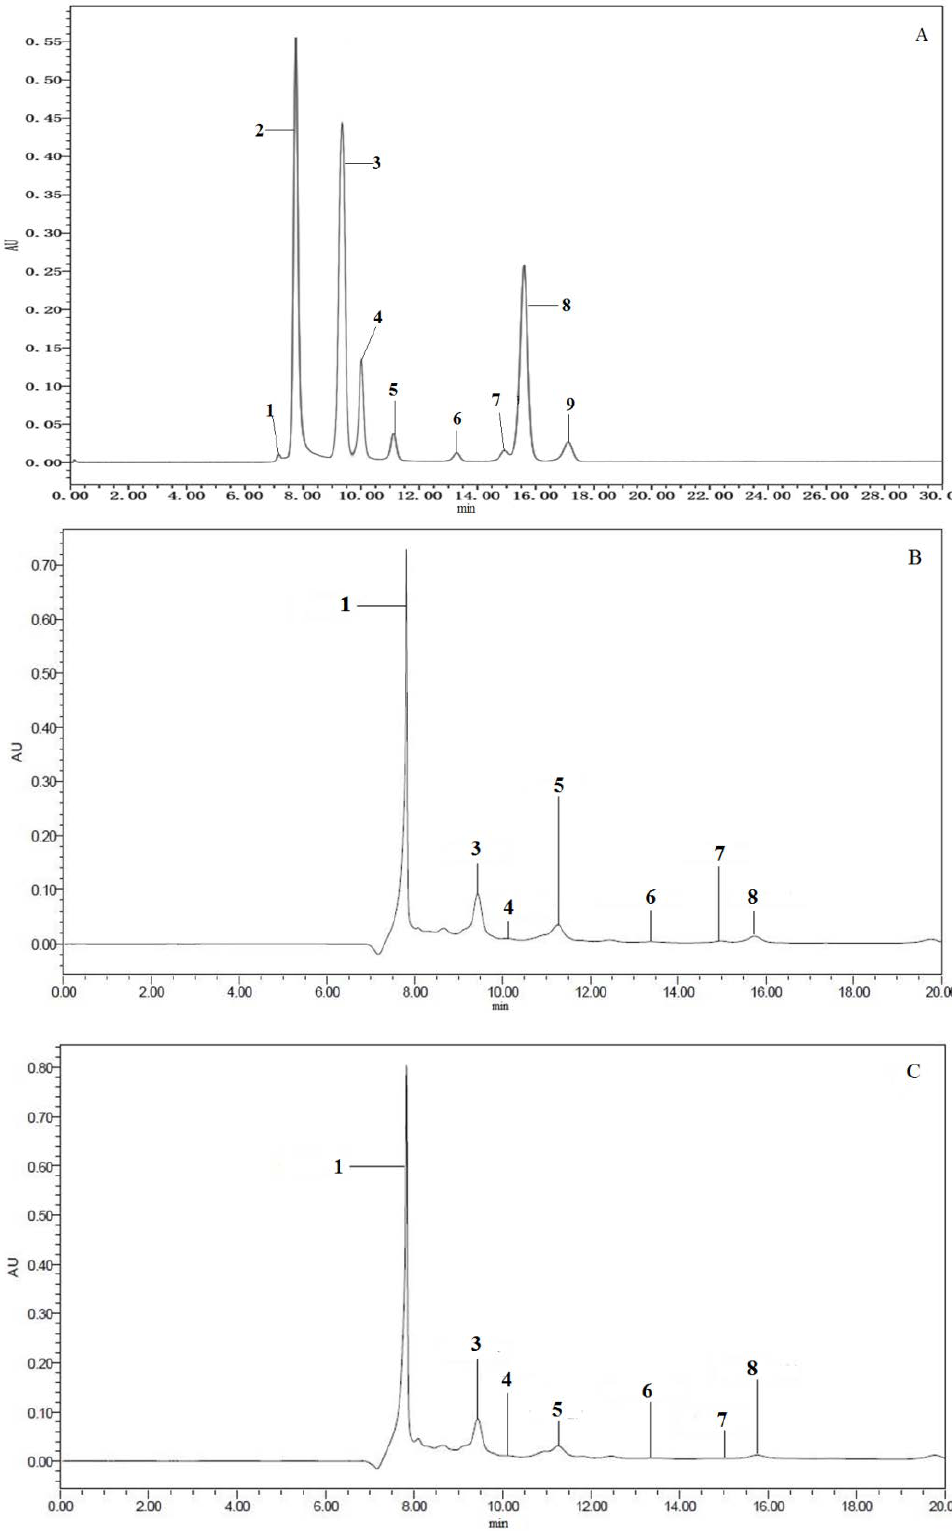
Figure 1. Results for organic acid analysis: ( A ) Standard solution of seven organic acids (1: Oxalic acid; 2: Ketoglutaric acid; 3: Citric acid; 4: Tartaric acid; 5: Malic acid; 6: Succinic acid; 7: Lactic acid; 8: Fumaric acid; 9: Adipic acid); ( B ) Sample 1; ( C ) Sample 2.